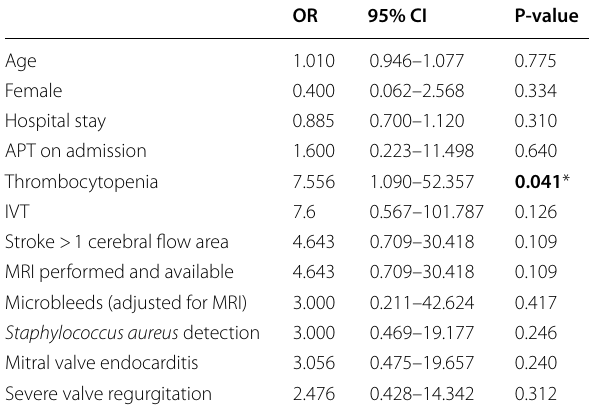
Table 3 Intracranial hemorrhage, univariate logistic regression analysis